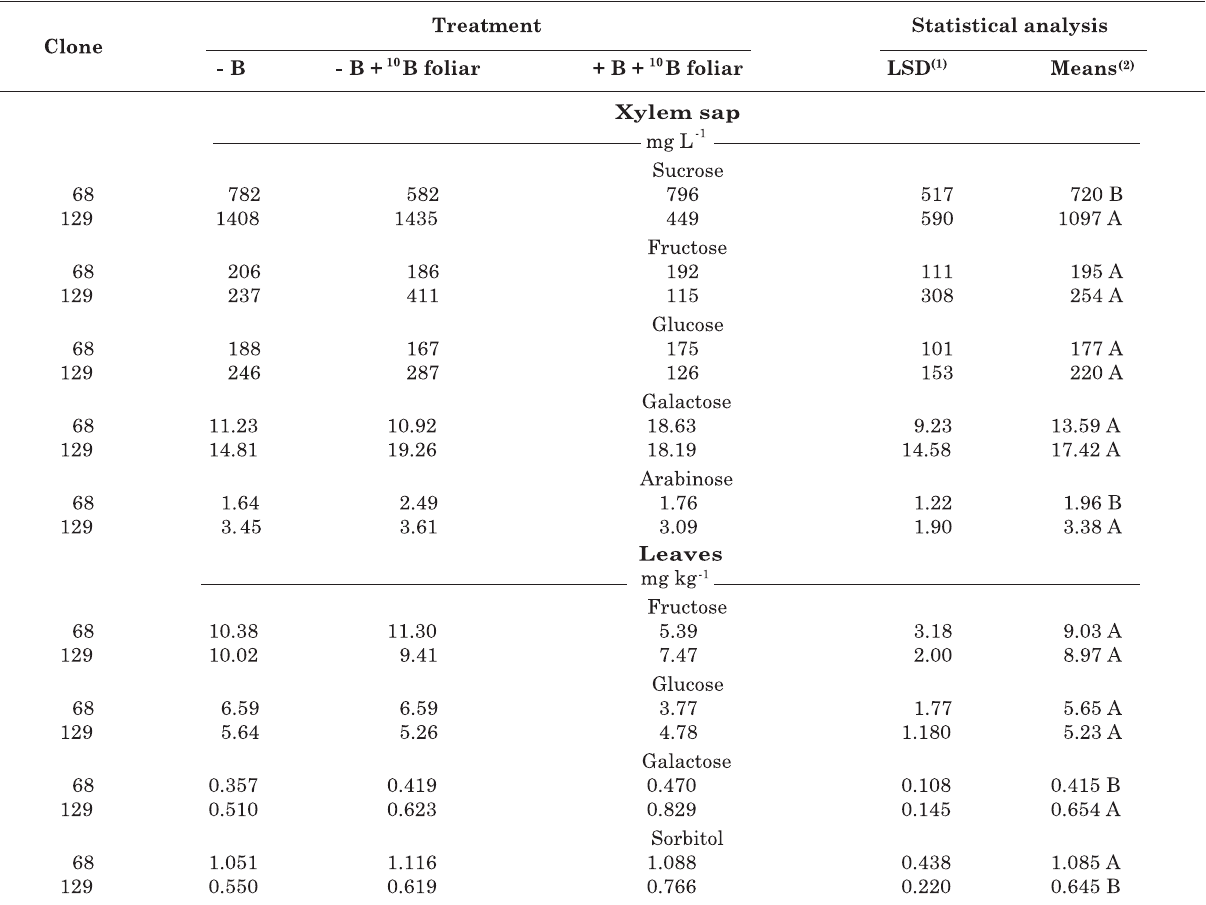
Table 3. Soluble carbohydrates in the xylem sap and in eucalypt leaves after 10 B foliar application to B-